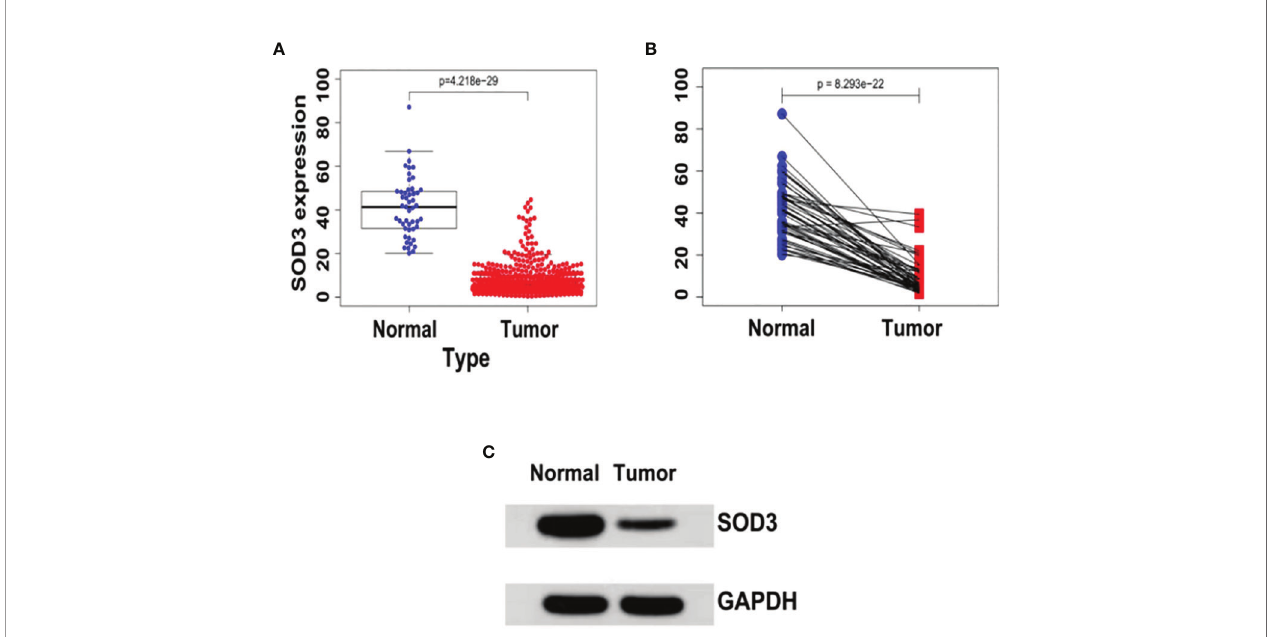
FIGURE 1 | (A) The expression levels of SOD3 in LUSC tissues (n = 502) and normal tissues (n = 49) derived from the TCGA database (TCGA-LUSC).wilcoxTest - P < 0.05. (B) SOD3 expression in LUSC tissue and paracancerous tissue.wilcoxTest - P < 0.05. (C) Western blot shows that SOD3 expression is downregulated in tumor